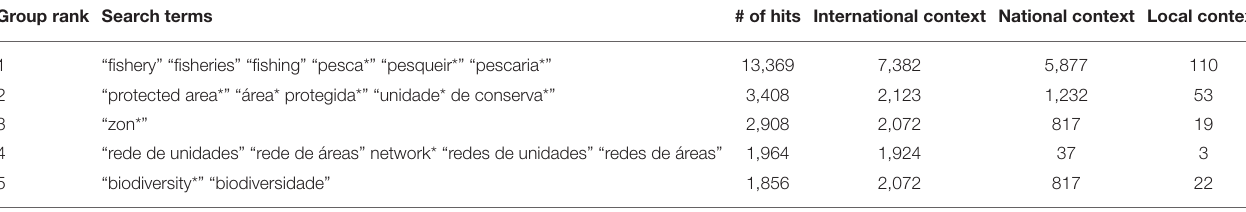
TABLE 4 | Percentage of documents that contain each groups of search terms, according to the lexical analysis for the three spatial contexts, for the top 5 search terms regarding the number of hits (appearances) for each group of search terms, considering all contexts together. Group rank Search terms